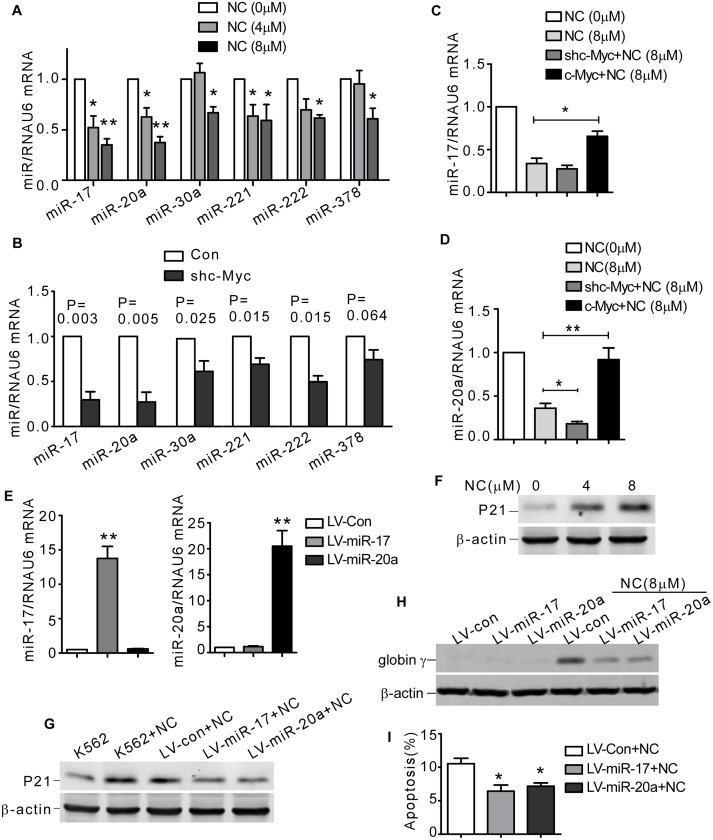
NC downregulated c-Myc activated miRNAs.(A) K562 cells were treated with 0, 4 or 8 μM NC for 2 days, the relative levels of mature miR-17, miR-20a, miR-30a, miR-221, miR-222 and miR-378 were detected by real-time qRT-PCR. The values represent the means ± S.E. (n = 3). *, P<0.05. **, P<0.01. (B) K562 cells were stably transfected with shc-Myc or control (Con). The relative expression of miR-17, miR-20a, miR-30a, miR-221, miR-222 and miR-378 was detected by real-time qRT-PCR. The values represent the means ± S.E. (n = 3). (C and D) Stably transfected K562 cells with shc-Myc, pIRES-c-Myc or control plasmid were exposed to NC for 2 days. The relative expression of mature miR-17 (C), miR-20a (D) was detected by real-time qRT-PCR. The values represent the means ± S.E. (n = 3). *, P<0.05. **, P<0.01. (E) The K562 cells were infected with LV-miR-17, LV-miR-20a or control (LV-con) lentiviral particles for 3 days, and the relative level of mature miR-17 and miR-20a was detected by real-time qRT-PCR. The values represent the means ± S.E. (n = 3). **, P<0.01. (F) K562 cells were treated with 0, 4 or 8 μM NC for 2 days, and then p21 and β-actin were detected by western blot. (G and H) After infection with LV-miR-17, LV-miR-20a or control lentiviral particles for 3 days, K562 cells were treated with NC (8 μM) for additional 2 days. p21 and globin γ were detected by western blot. β-actin was used as loading control. (I) After infection with LV-miR-17, LV-miR-20a or control lentiviral particles for 3 days, K562 cells were treated with NC (4 μM) for additional 2 days. Apoptosis rate was detected by annexin V/PI double staining. The values represent the means ± S.E. (n = 3). *, P<0.05.